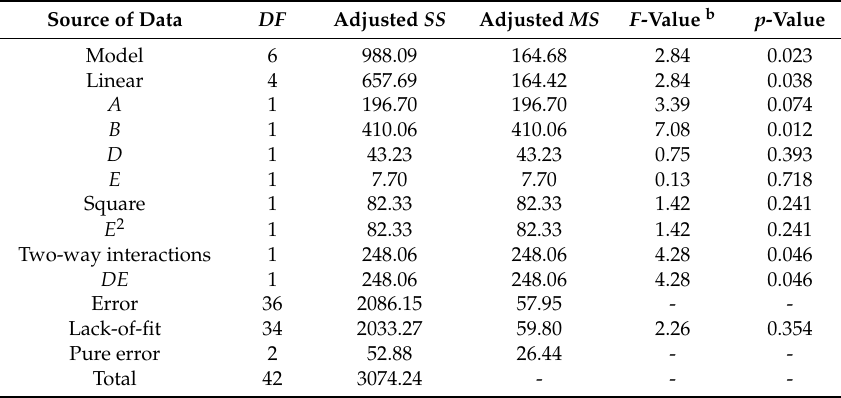
Table 3. Outputs of analysis of variance (ANOVA) and the lack-of-fit test for the response surface regression model established using the forward-selection-of-terms algorithm ( α to enter = 0.25) for the pulse-modulated radio-frequency atmospheric-pressure glow discharge (pm-rf-APGD) plasma-reaction system used for synthesis of silver nanoparticles (AgNPs) a